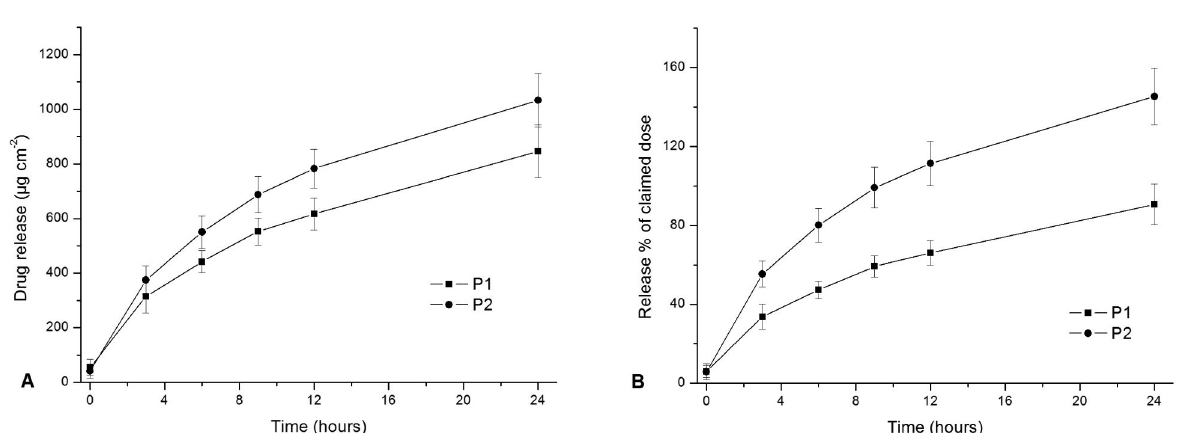
FIGURE 2 - Release profiles from nicotine commercial patches P1 (■) and P2 (●) using the VDC method, n = 6. Results are expressed as the cumulative amount of drug released (A) and the cumulative % of dose released